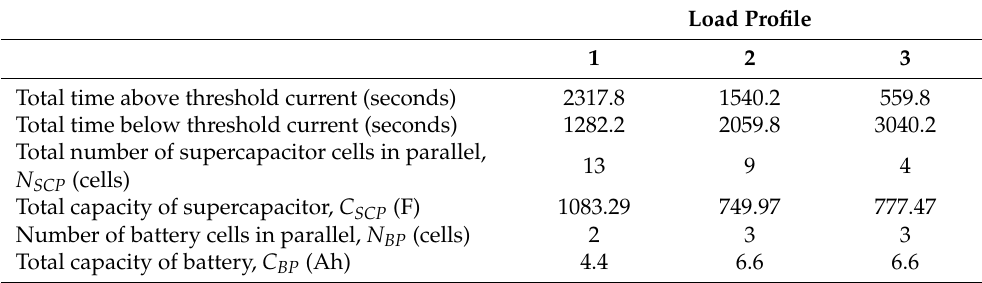
Table 7. Sizing results of battery–supercapacitor HESS.